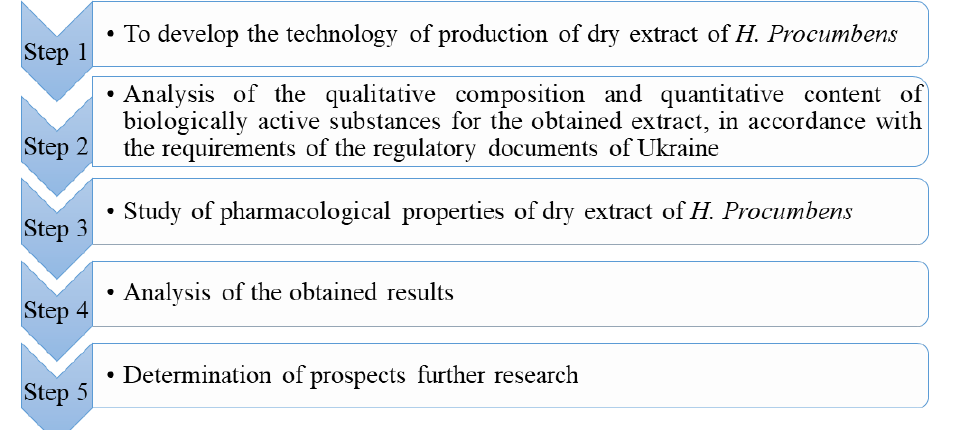
Fig. 2. Research planning